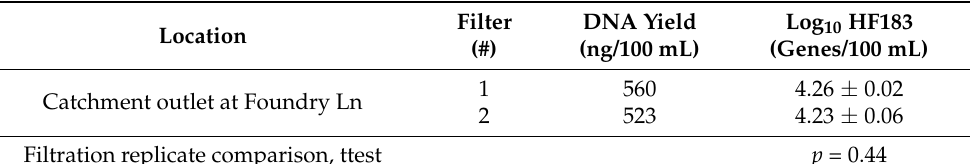
Table A3. DNA yield and HF183 gene copies for 350 mL volumes of Ouseburn River water collected at the catchment outlet at Foundry Ln and analyzed onsite, showing the data for each filter replicate. qPCR results are the average and standard deviation of triplicate analysis from each DNA extract.